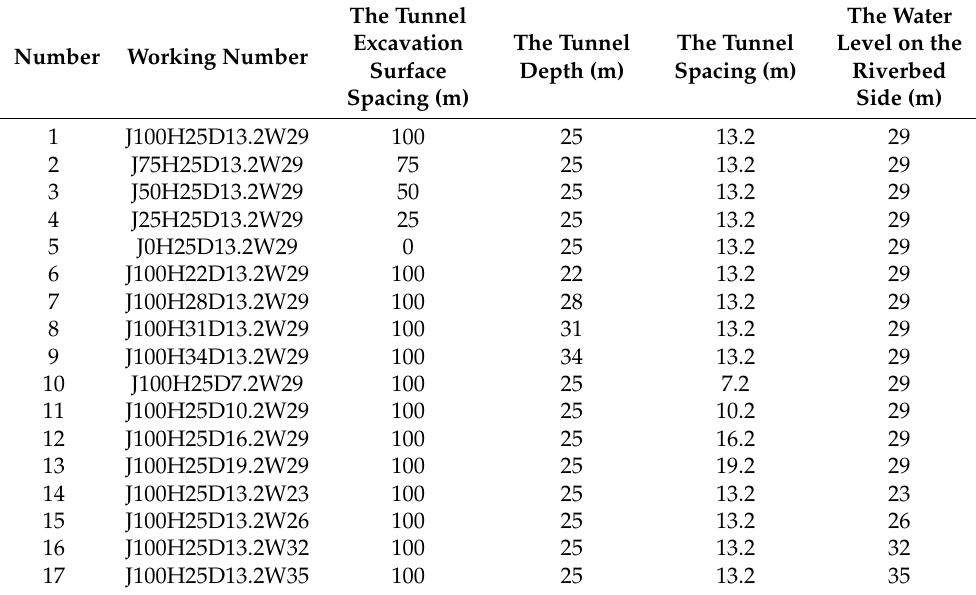
Table 2. Working conditions of four